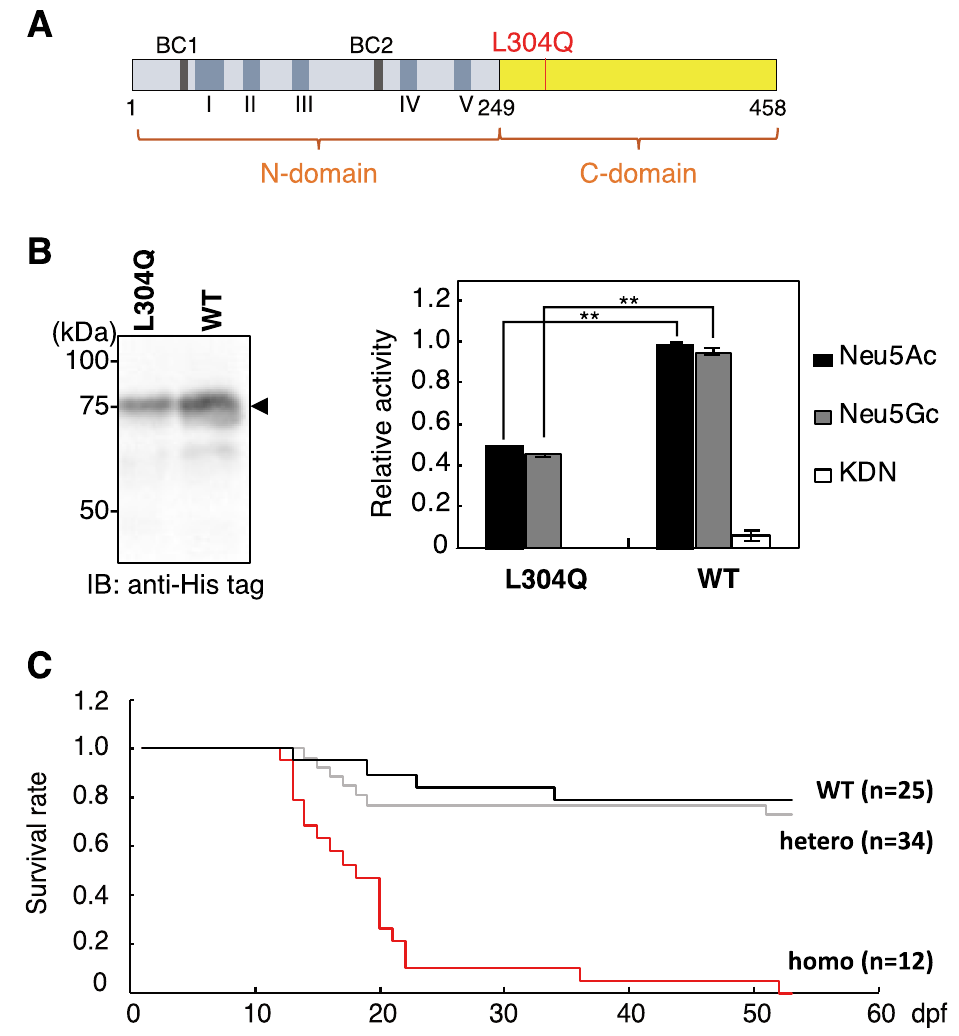
Figure 1. Properties of L304Q mdkCSS and survival curve of L304Q homo medaka. ( A ) Schematic drawing of L304Q mdkCSS. The position of L304Q site is shown by red bar. I ~ V, the evolutionarily conserved amino acid sequence motifs; BC1 and BC2 represent basic amino acid clusters that may be functional as nuclear localization signals. ( B ) Enzyme activity of L304Q mdkCSS. Left , western blotting of the recombinant L304Q and WT using anti-His antibodies was performed for quantifying the enzyme amount. Right , the relative specific activity of L304Q and WT in relation to Neu5Ac, Neu5Gc and KDN. The specific activity of WT in relation to Neu5Ac was set to 1. The bars represent standard deviation from three independent experiments. ( C ) Survival curve of medaka with the L304Q mutation in the CSS gene. WT, hetero, and L304Q homo medaka were derived from in-crossing of the same L304Q hetero parents. The numbers (n) of fish examined are shown in the parentheses. **indicates p < 0.005. Full-length blots for ( B ) are presented in